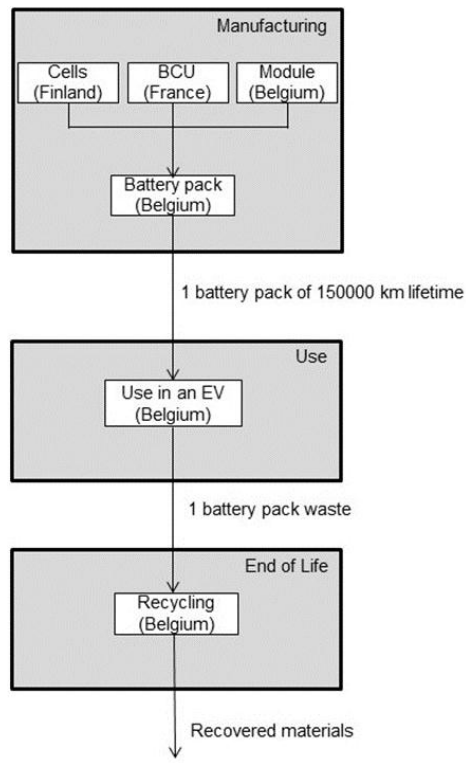
Figure 1. Life cycle stages of the studied system and location.